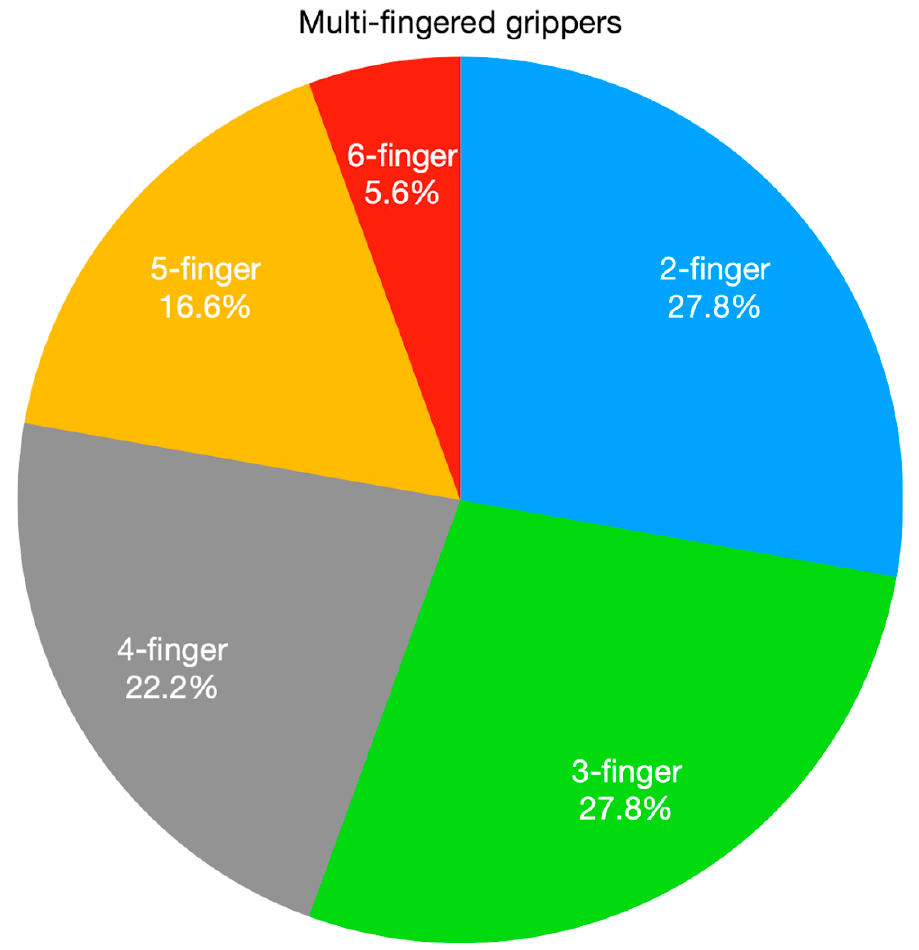
Figure 12. Types of contact-grasping grippers in the referenced literature based on the number of fingers.